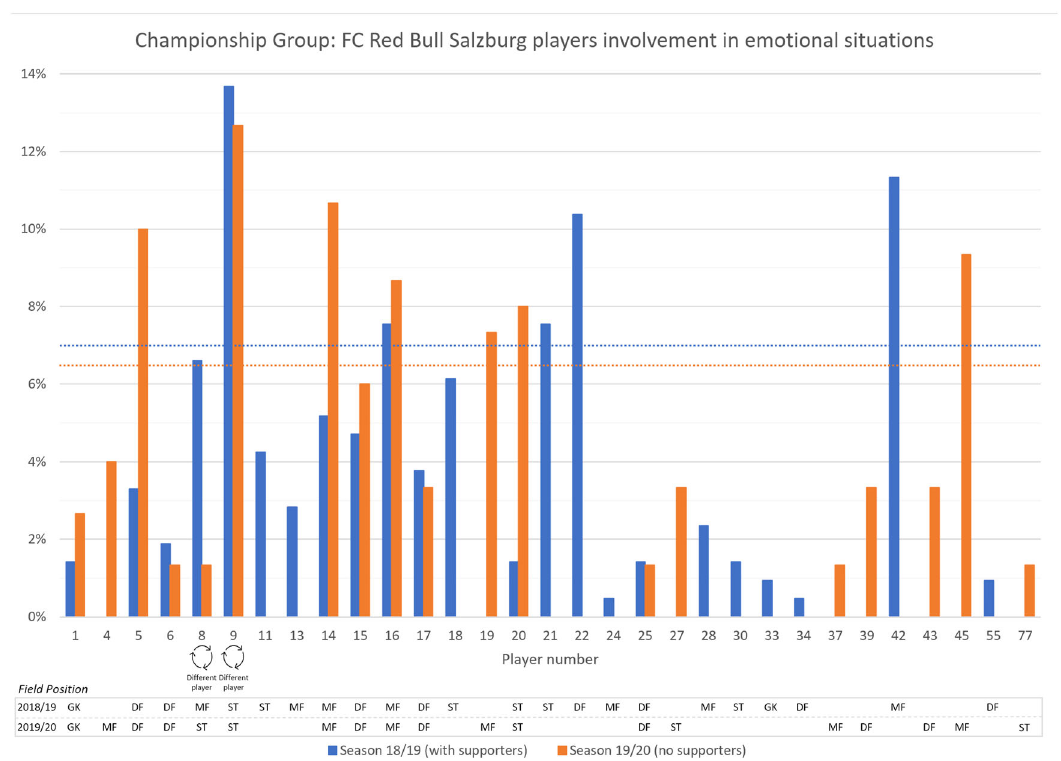
Fig. 2 FC Red Bull Salzburg players involvement in emotional situations. Relative number of involvements of FC Red Bull Salzburg (RBS) players in documented emotional situations of 20 matches in the championship group phases of season 2018/19 and 2019/20. Results indicate that in 18/19, fi ve players can be identi fi ed as “ high involvement players ” . We de fi ne “ high involvement players ” as players who are documented more than half of the most involved player per season. That is more than 6.9% (blue dotted line) for season 18/19 (with number 9 (Dabbur) involved in 13.7% of all situations) and 6.4% (orange dotted line) for season 19/20 (with number 9 (Hwang) involved in 12.7% of all situations). Additional information is provided by illustration of players ’ fi eld position in respective seasons (GK goalkeeper, DF defender, MF mid fi elder, ST striker). Except for number 8 — which was worn by two different players — all players kept their fi eld position role in both seasons. Thus, in season 18/19 there are 5 “ high involvement players ” : 9 (Dabbur) (ST), 16 (Junuzovic) (MF), 21 (Gulbrandsen) (ST), 22 (Lainer) (DF) and 42 (Schlager) (MF). Two players (9 & 42) had more involvements than any other player in season 19/20. In season 19/20 there are 7 “ high involvement players ” : 5 (Vallci) (DF), 9 (Hwang) (ST), 14 (Szoboszlai) (MF), 16 (Junuzovic) (MF), 19 (Camara) (MF), 20 (Daka) (ST) and 45 (Mwepu) (MF). Our data suggests that the relative number of interactions of RBS players in emotional situations did not change remarkably due to player transfers between seasons. Additionally, the roles (in terms of fi eld position) of the high involvement players are comparable between both seasons. While in season 2018/19 one defender, two mid fi elders and two strikers are de fi ned as “ high involvement players ” , in season 2019/20 one defender, four mid fi elders and two strikers are de fi ned as “ high involvement players ” . This similar distribution indicates that hierarchical and personalities structure in the various parts of the team is comparable between both seasons. Note that two numbers were worn by two different players in season 18/19 and 19/20. As illustrated with small arrows, these are number 8 (Samassékou & Berisha) and number 9 (Dabbur &